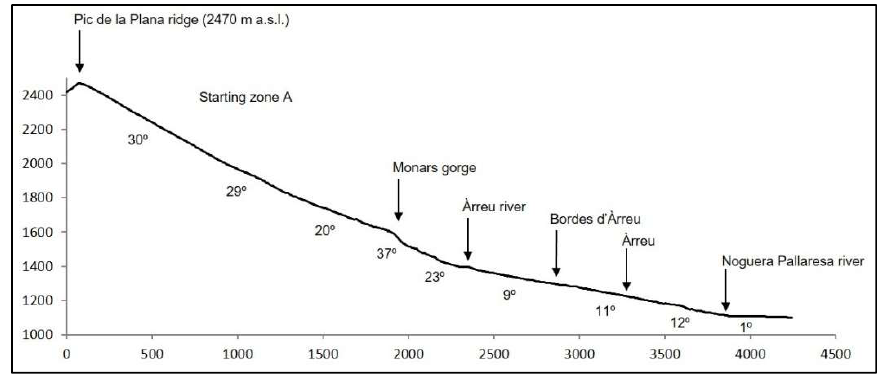
Figure 3. Topographical profile of the main centerline of the avalanche path, represented in Figure 1.